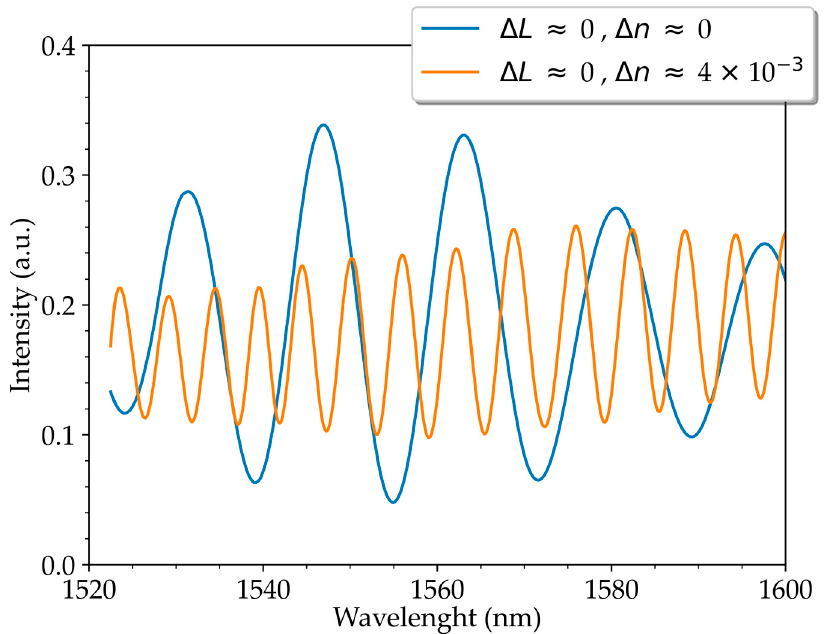
Figure 7. Normalized spectrum for: ( a ) balanced system (before adding two fibers of length 120 mm with different refractive indices) and ( b ) after adding two fibers of equal length, 120 mm, but different effective refractive indices.